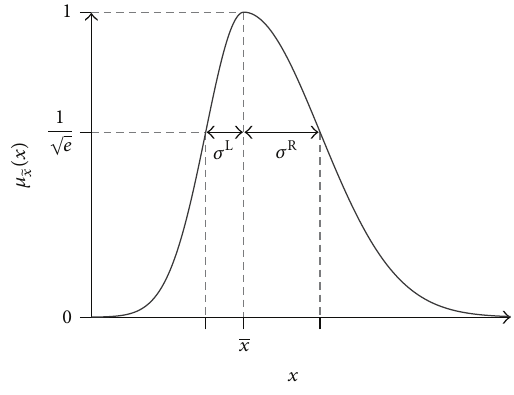
Figure 1: Triangular fuzzy number. Figure 2: Gaussian fuzzy